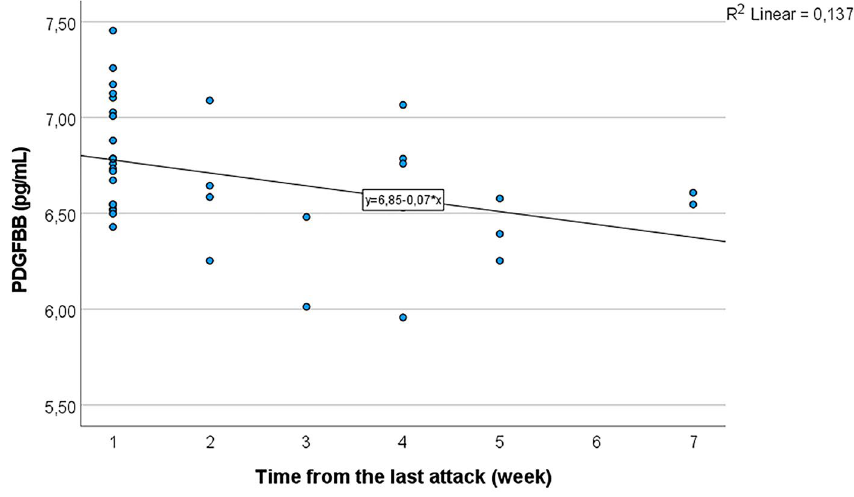
Figure 4. Correlations between the time of the last attack and PDGFBB in MD as demonstrated by linear regression. p < 0.05